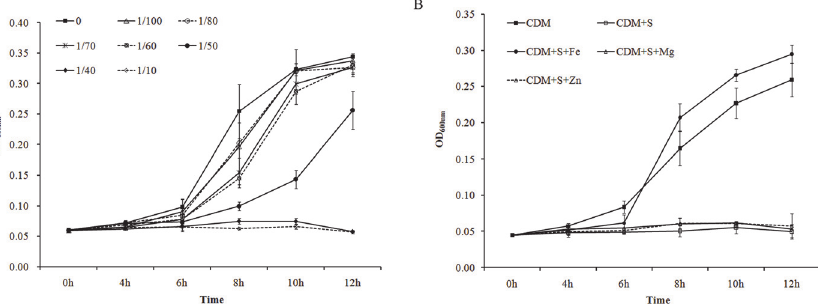
Fig 1. The effect of serum on A . pleuropneumoniae growth in chemically defined medium (CDM). A . pleuropneumoniae was cultured in TSB medium overnight and then sub-cultured into CDM at a dose of 10 4 CFU/ml. Optical densities of bacterial cultures (OD 600nm ) were recorded at selected time points. (A) Various concentrations of serum (0 – 1/10; V/V) were added into CDM; (B) Serum at the concentration of 1/40 was added into CDM (CDM + S). FeCl 3 , MgCl 2 and ZnCl 2 were supplemented into the serum-containing medium respectively (CDM + S + Fe/Mg/Zn). A . pleuropneumoniae cultured in CDM without any supplementation was used as a control (CDM). Data are shown as means ± SD from four independent